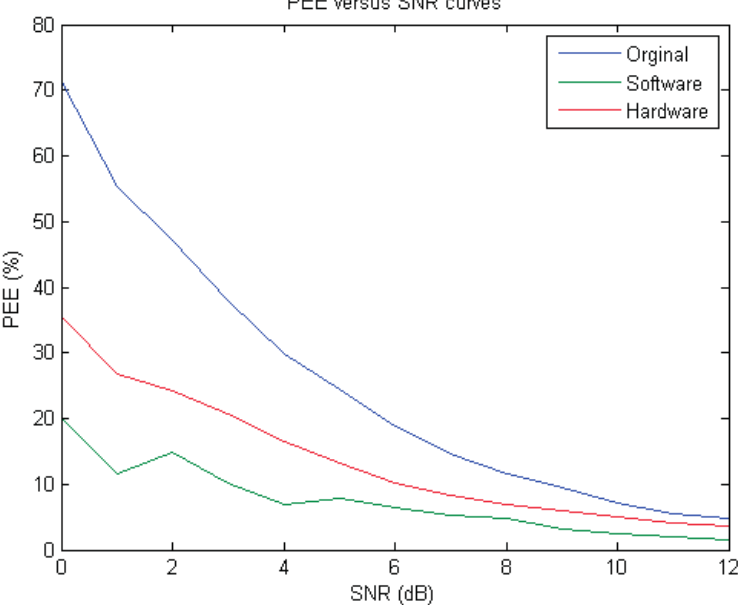
Figure 16. The Percent Error Energy (PEE)- versus -signal-to-noise ratio (SNR) curves derived from the original noise-corrupted ECGs (blue), the software-based de-noised ECGs (green), and the hardware-based de-noised ECGs (red),